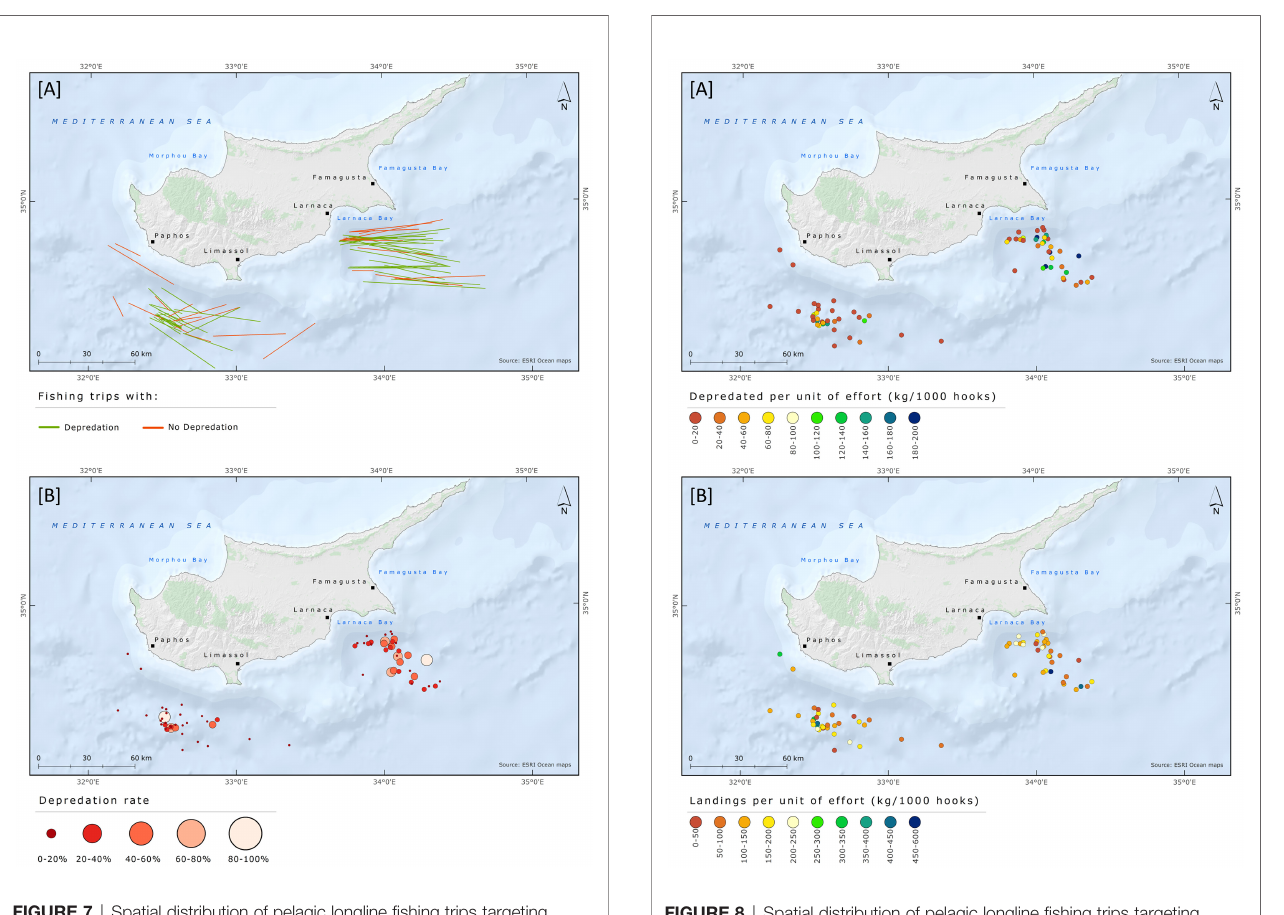
FIGURE 8 | Spatial distribution of pelagic longline fi shing trips targeting albacore tuna between June and August 2018 with information regarding (A) Discards Per Unit of Effort and (B) Landings Per Unit of Effort.